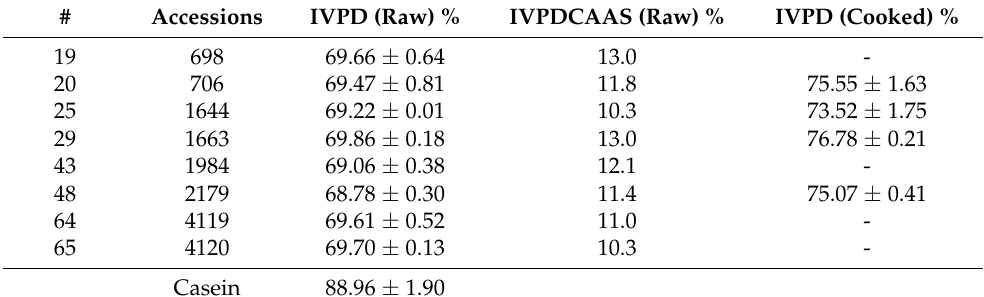
Table 3. In vitro protein digestibility (IVPD) and in vitro protein digestibility corrected by the limiting amino acid score (IVPDCAAS) in raw common bean accessions ( n = 8). The in vitro protein digestibility (IVPD) of cooked common bean accessions ( n = 4) was also presented.